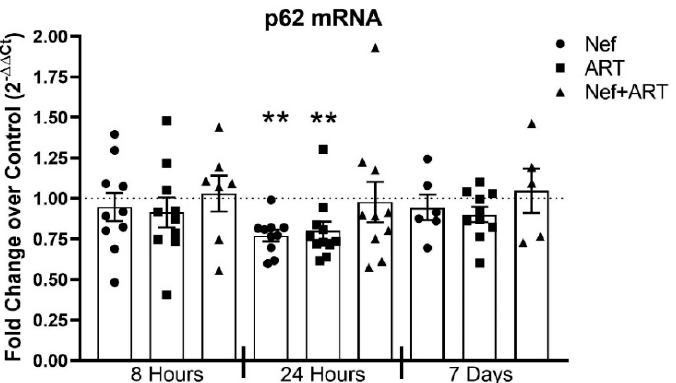
Figure 7. p62 mRNA transcription after treatment with Nef and / or ART for 8 or 24 h or 7 days. Primary human astrocytes were treated with extracellular Nef and / or ART for 8 or 24 h or daily for 7 days, and qRT-PCR was performed. Graph depicts the fold change of p62 mRNA over control of individual experiments (dots), and the mean of all experiments (bars). Control is depicted as the dashed line at 1. Error bars represent SEM. n = 5–10; **, p < 0.005; by the Wilcoxon Signed Rank test.